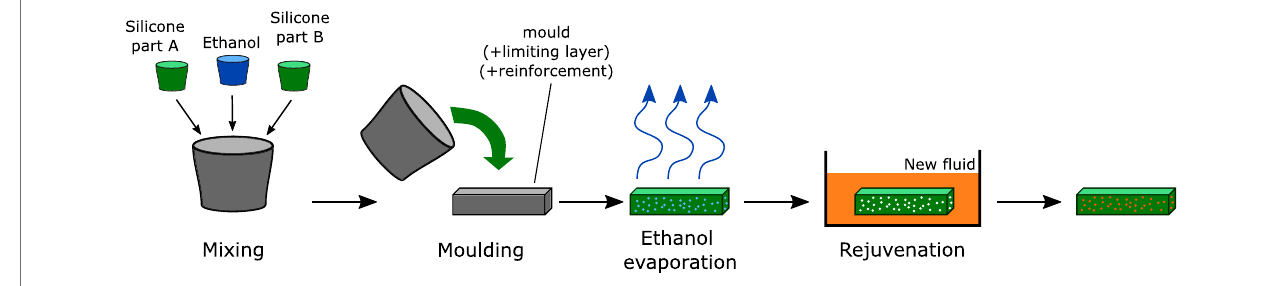
FIGURE 2 | Fabrication process of the PCMEC actuators.